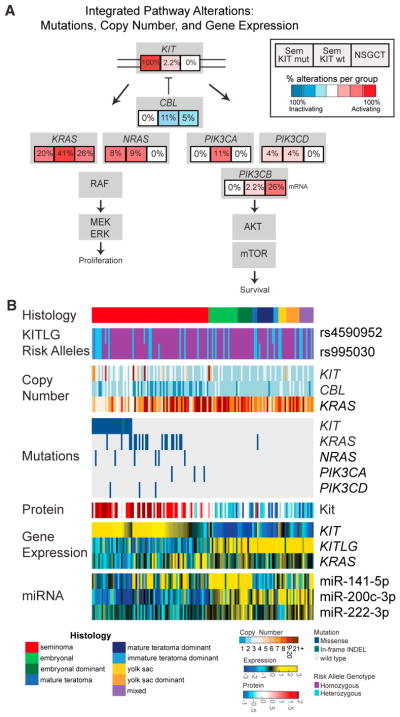
Analysis of KIT and KIT Ligand in TGCTs(A) Integrated analysis of the Kit pathway indicating the frequency of multiple genomic alterations within the Kit pathway.(B) A multiple platform characterization of KIT and KIT ligand across testicular germ cell tumors. Samples are first ordered by tumor histology. Within histology, tumors are ordered by KIT mutation status and then by KIT mRNA expression from high to low. Missing values are depicted as blank or white space within each heatmap.See also Figure S7.